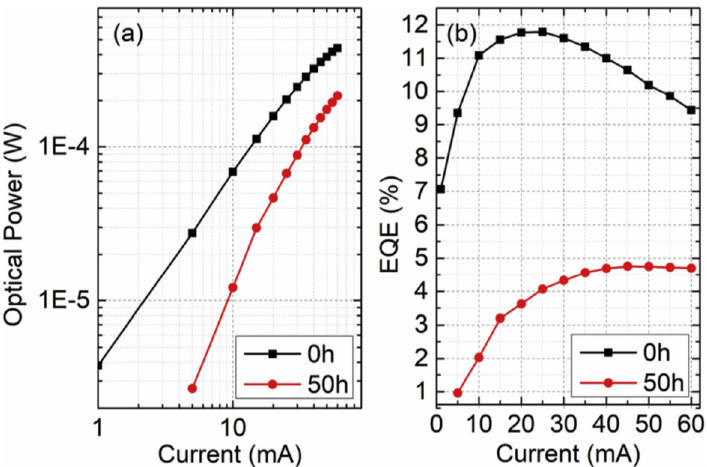
Figure 9. ( a ) Optical power and ( b ) EQE dependence on the forward current for LED B before and after 50 h aging. Reproduced with permission. [47] Copyright 2019, Elsevier.